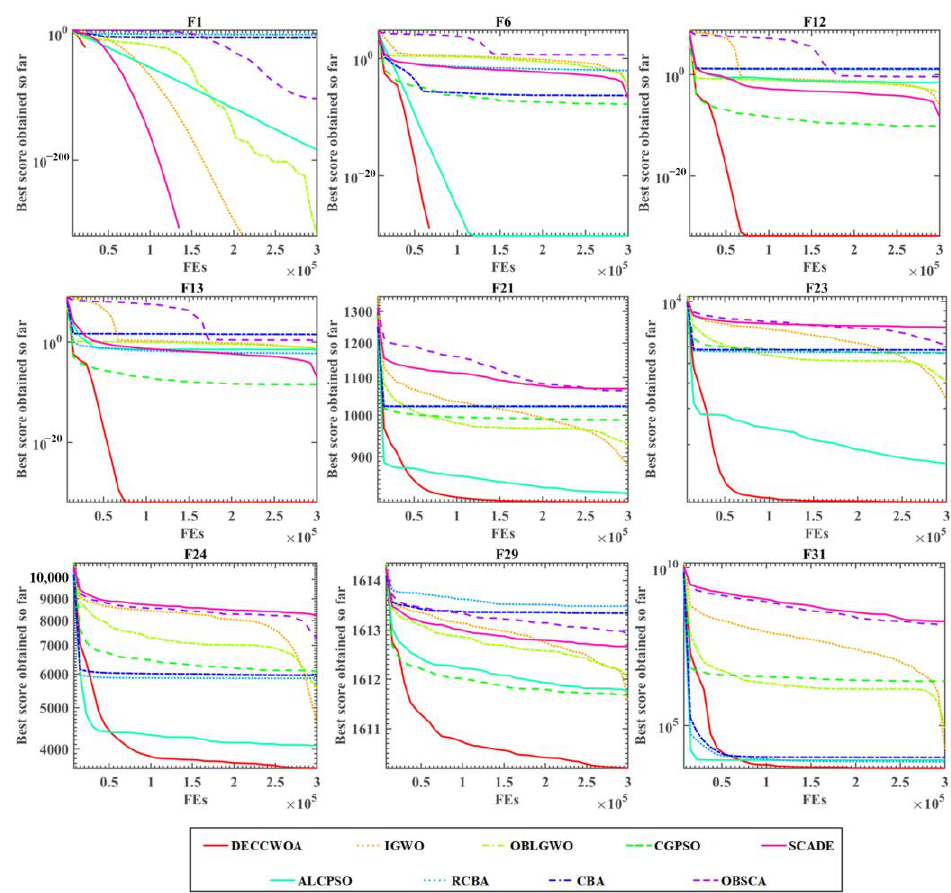
Figure 6. Convergence curves of the DECCWOA and advanced algorithms.